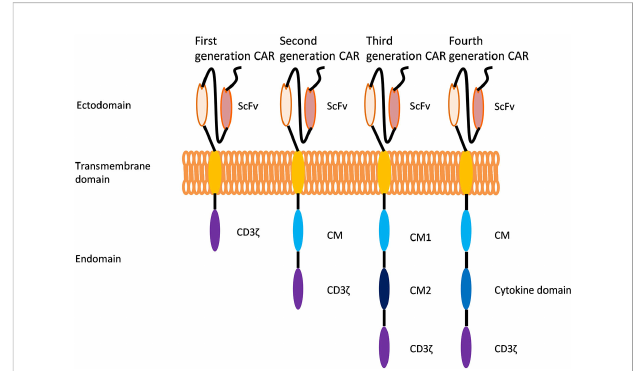
FIGURE 1 Evolution of chimeric antigen receptors (CARs). Each CAR generation contains an extracellular single-stranded variable region (scFv), an intracellular CD3 domain (CD3 z ) and a T-cell receptor transmembrane domain. The fi rst generation of CARs has only the CD3 domain in the cell. The second generation of CARs includes the CD3 domain and the costimulatory domain (CM). Developed on the basis of second- generation CARs, the third generation of CARs has two different costimulatory domains in the cell. Developed based on the structure of second-generation of CARs, fourth-generation of CARs have an additional intracellular domain that regulates the expression of cytokines or other costimulatory molecules.